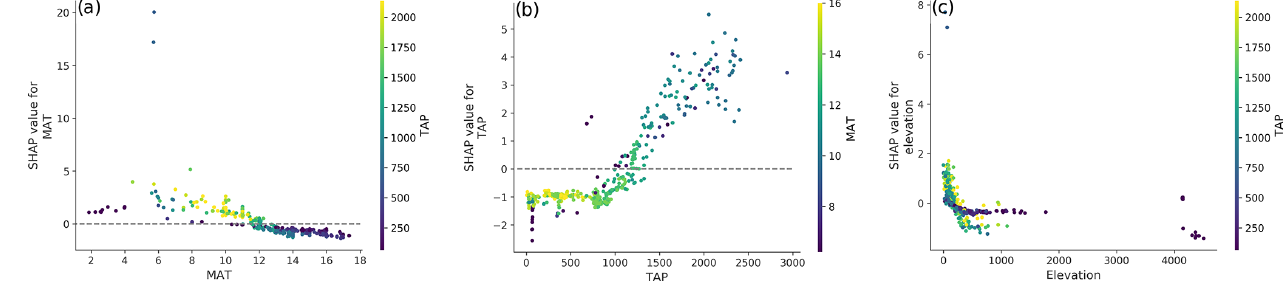
Figure 5. Dependency plots between SHAP values and selected covariates: (a) between SHAP values and mean annual temperature (MAT), showing the interaction with total annual precipitation (TAP; colour scale); (b) between SHAP values and total annual precipitation, showing the interaction with mean annual temperature (colour scale); and (c) between SHAP values and elevation, showing the interaction with total annual precipitation (colour scale).